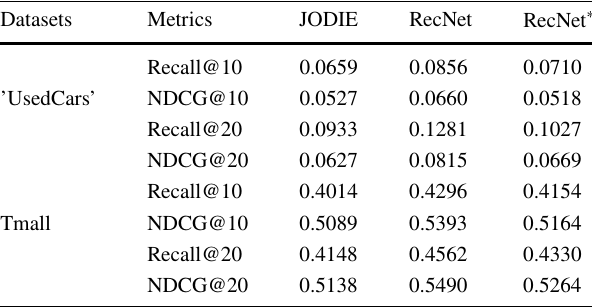
*denotes that the resource constraint branch is removed from